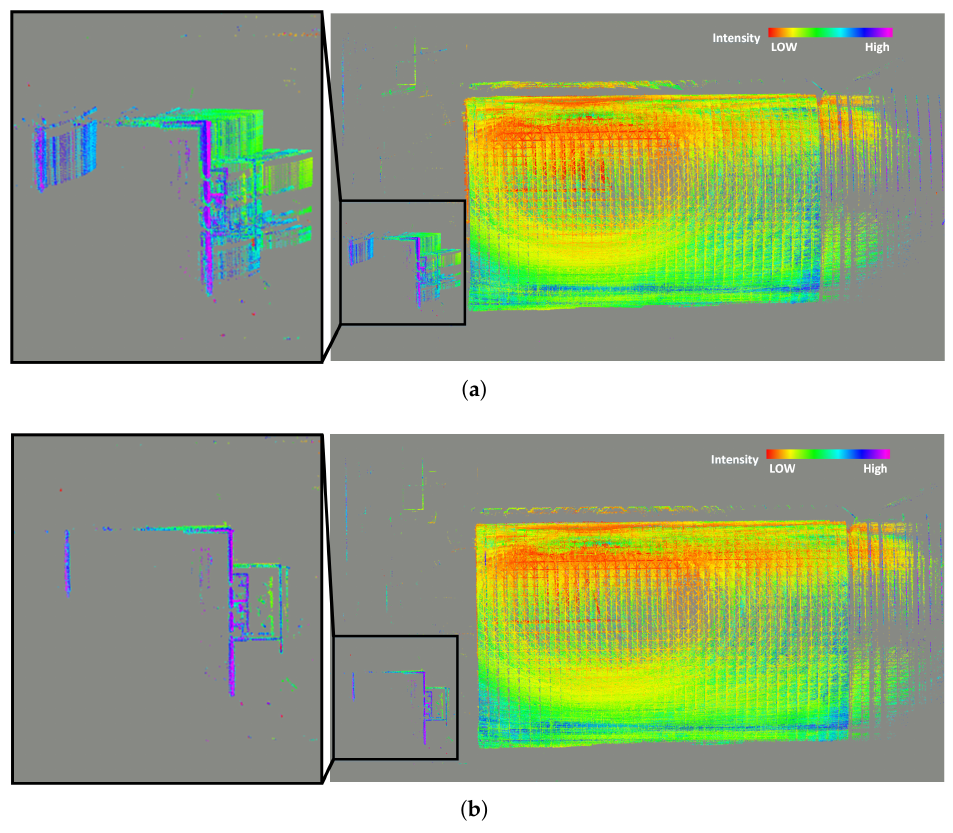
Figure 12. The top view of the point cloud map. ( a , b ) are the top views of the point cloud maps built by LIO-SAM and the proposed navigation system, respectively.